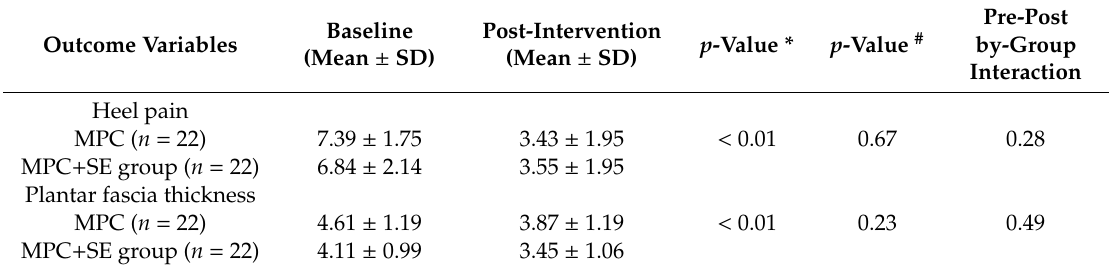
Table 2. Heel pain and plantar fascia thickness by treatment group over